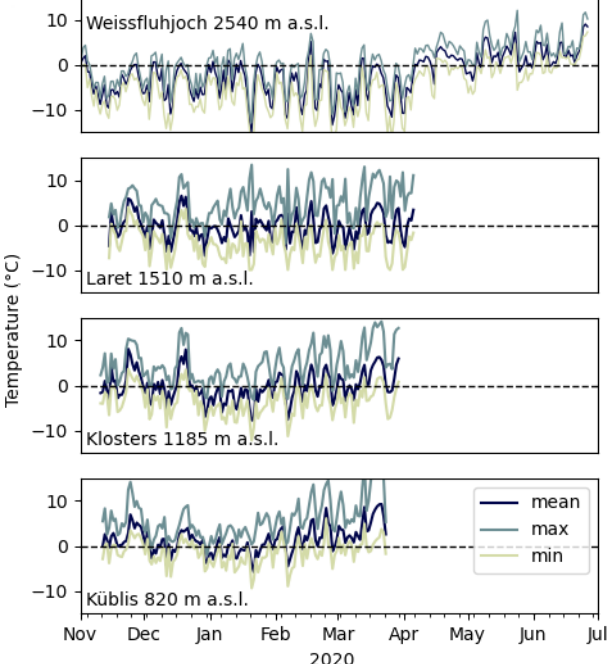
Figure A2. Mean, maximal and minimal daily air temperature for 2019–2020 at the four sites Weissfluhjoch 2540ma.s.l., Laret 1510ma.s.l., Klosters 1185ma.s.l. and Küblis 820ma.s.l. The maximum temperatures at the Klosters and Küblis may be generally too high since we used unventilated